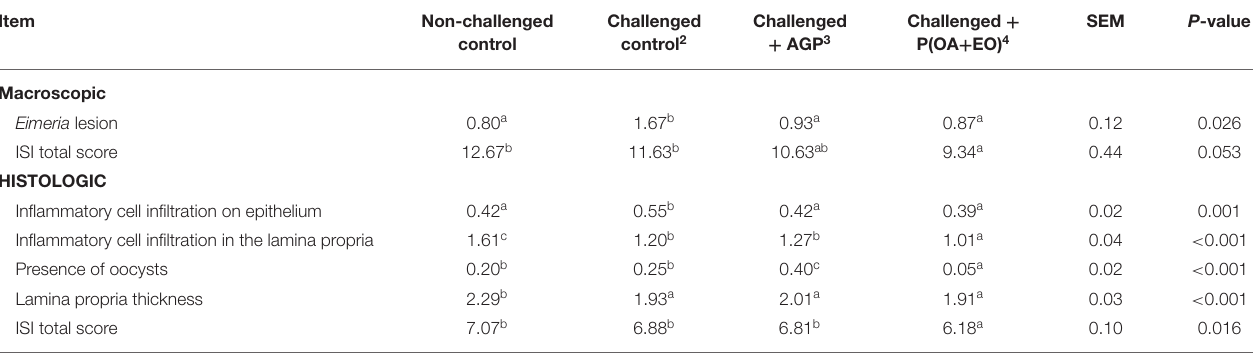
TABLE 5 | I See Inside (ISI) responses at 21 d of broiler chickens undergoing an intestinal challenge and fed diets supplemented or not with an antibiotic growth promoter (AGP) or a protected blend of organic acids and essential oils [P(OA + EO)] 1